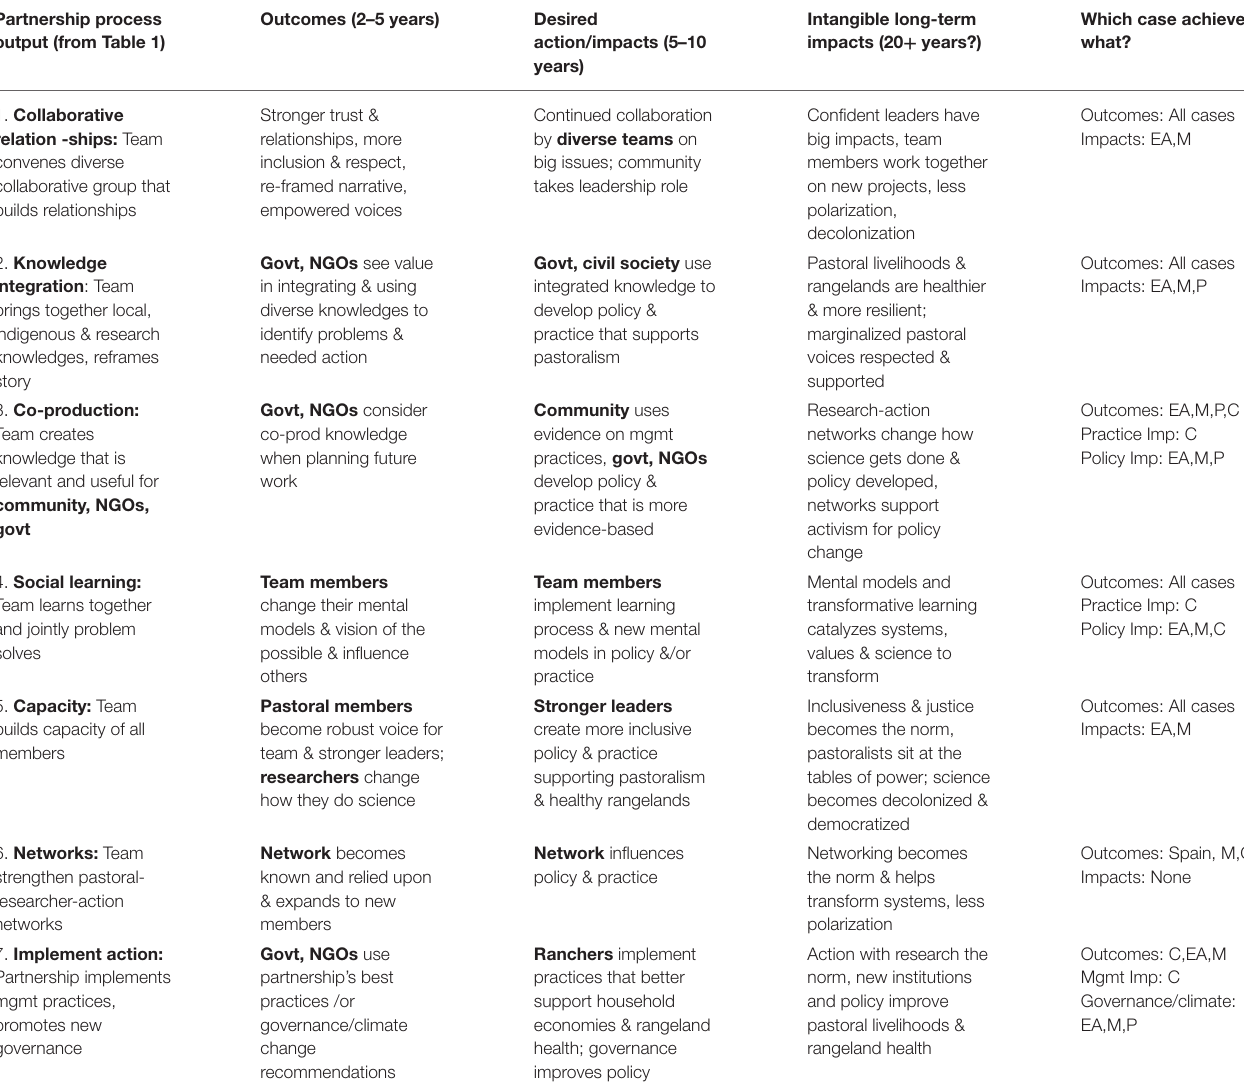
TABLE 2 | Seven types of impact pathways as a result of process outputs partners implement that form a ‘process’ a theory of change for our rangeland partnerships. Partnership process output (from Table 1)